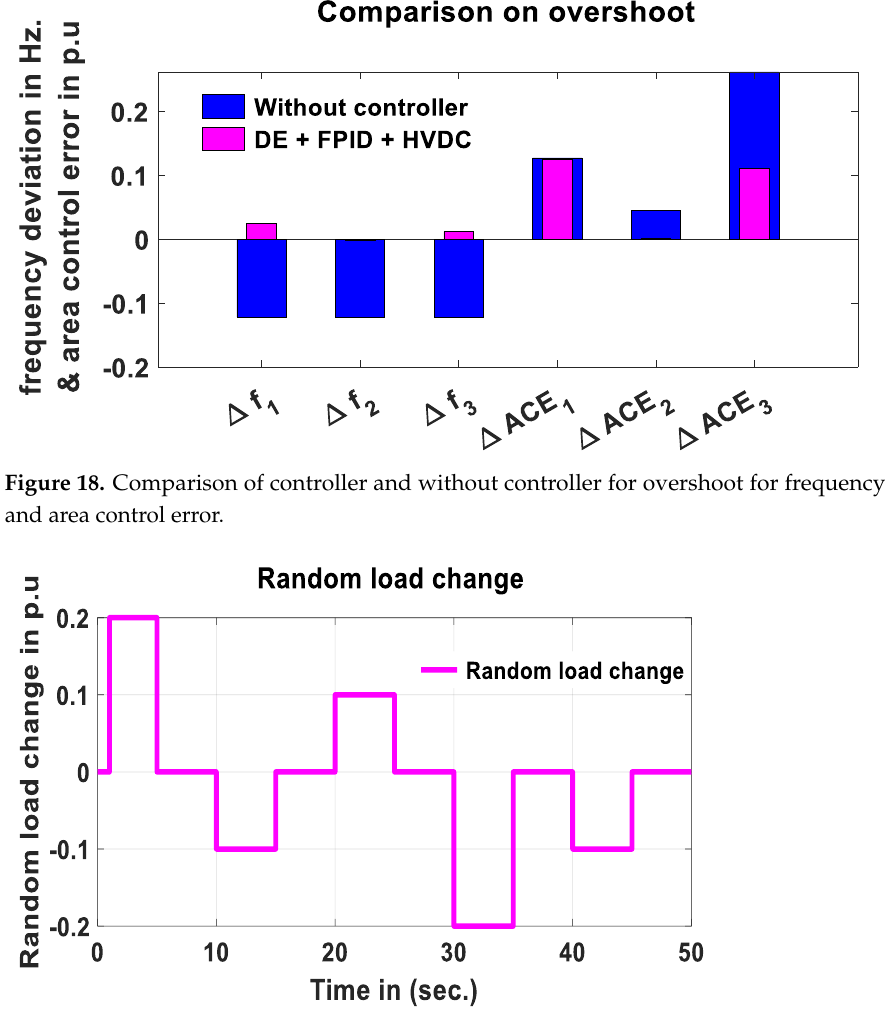
Figure 20. Frequency response of f1, f2 and f3 due to random load change. Figure 21. Change in frequency responses of area 1,area 2, and area 3 for random load change in area 1 only.